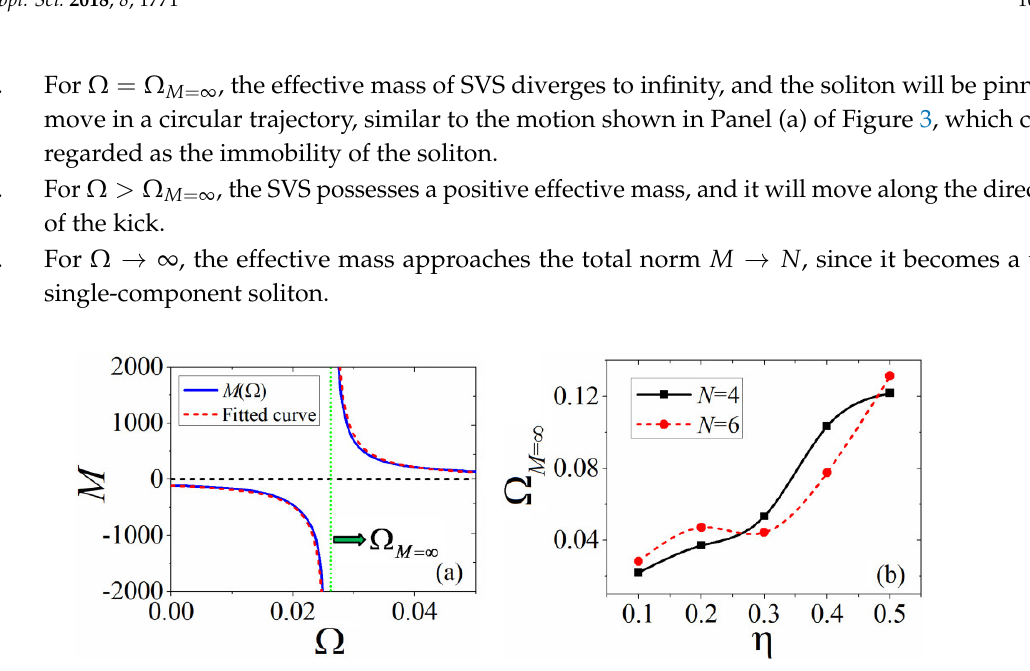
Figure 8. Effective mass M of the SVS in spiral motion controlled by the Zeeman splitting Ω . ( a ) M versus Ω with N = 5 and fixed kick k = 0.2. Divergence occurs at Ω M = ∞ = 0.0262. The dashed curve is the fitting 3/ ( Ω − Ω M = ∞ ) . ( b ) Ω M = ∞ vs. the kick strength η with different N